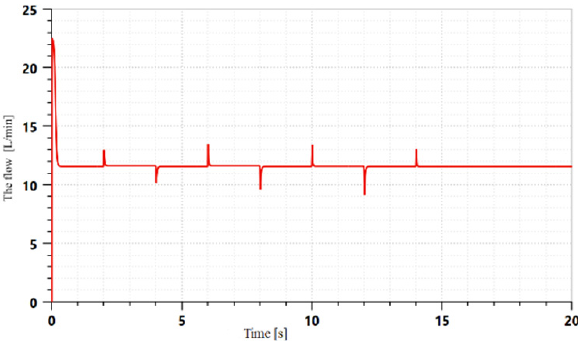
Figure 19. Viscous damping coefficient of 20,000 N/(m·s).